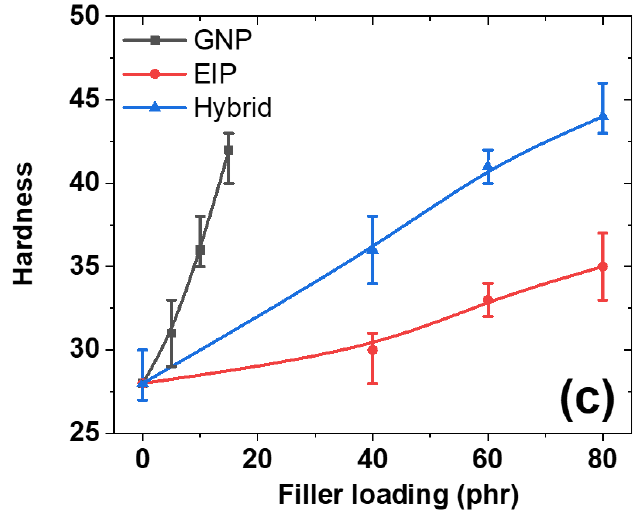
Figure 5. The experimental values compared to the theoretical modeling: ( a ) compressive modulus and prediction through models; ( b ) tensile moduli and their prediction through models; ( c ) hardness of different composites.